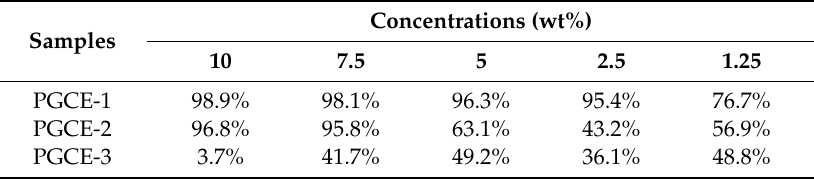
Table 3. Transmittances of polyglyceryl-10 caprylates aqueous solutions at di ff erent